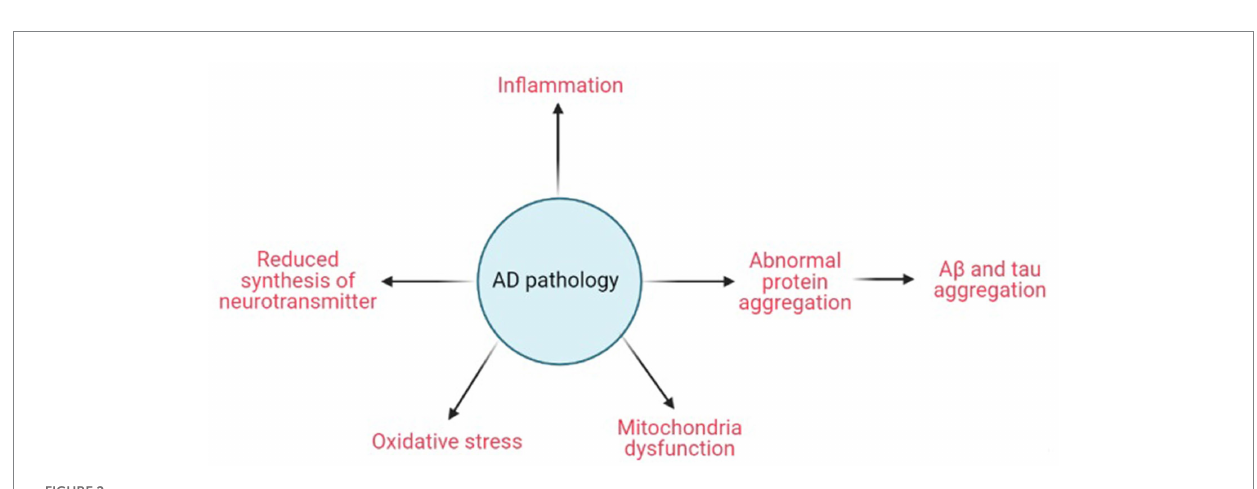
FIGURE 2 Schematic diagram of AD pathology. Created with